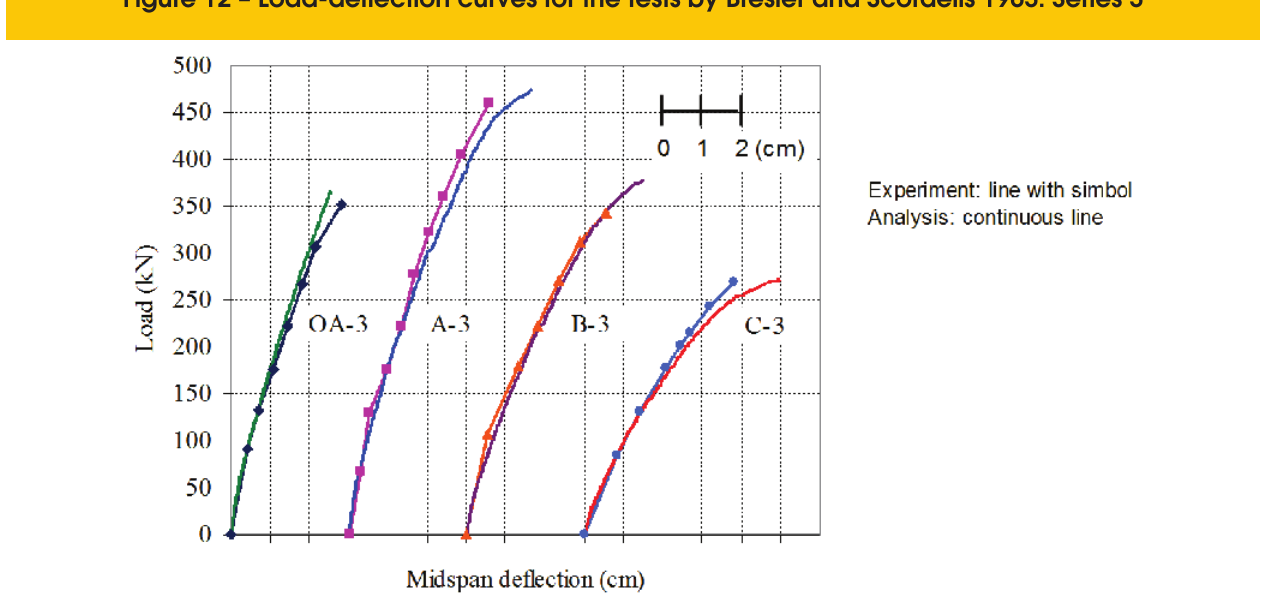
Figure 12 – Load-deflection curves for the tests by Bresler and Scordelis 1963: Series 3